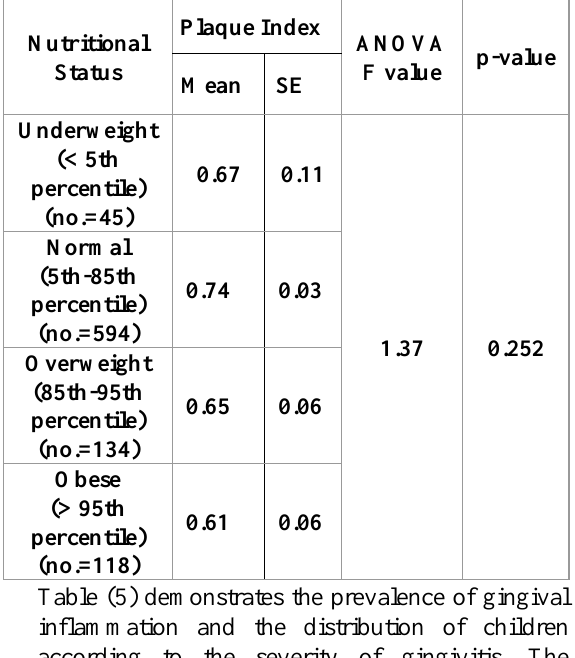
Table 4: Plaque index by nutritional status.